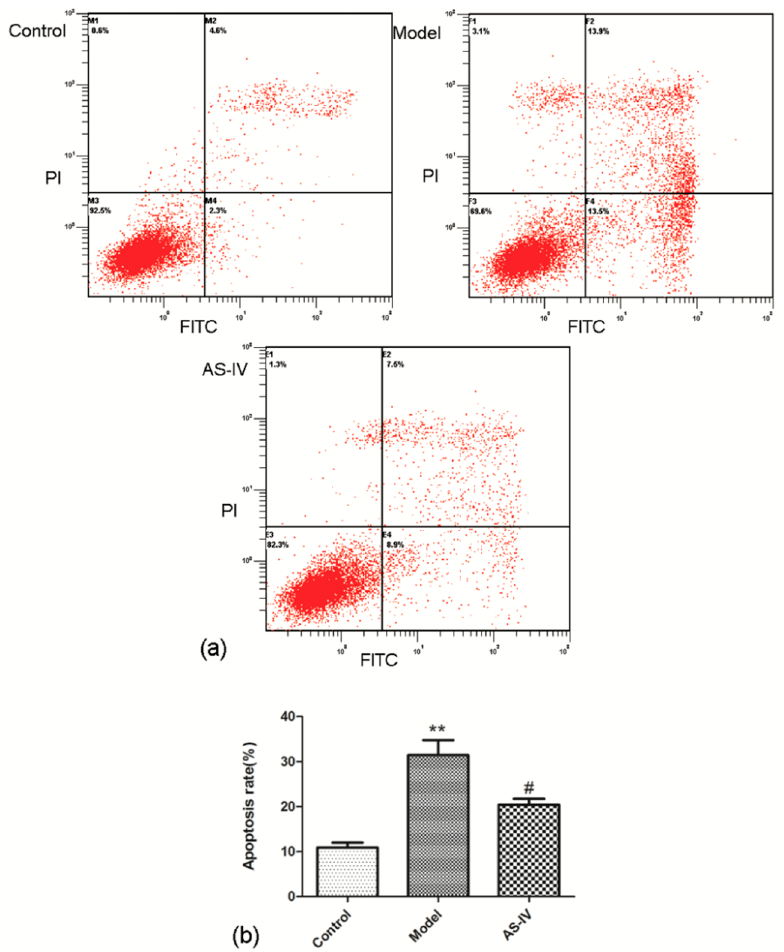
Figure 6. Anti-apoptosis e ff ect of Astragaloside IV in HT22 cells after OGD / R. The changes in the apoptosis rates in the HT22 cells by OGD / R with Astragaloside IV treatment examined by a flow cytometry with Annexin V-FITC / PI staining (means ± SD, n = 3, ** p < 0.01 vs. control and # p < 0.05 vs. model). ( a ) Representative photographs obtained from each group. ( b ) Quantitative assessment of apoptotic cell